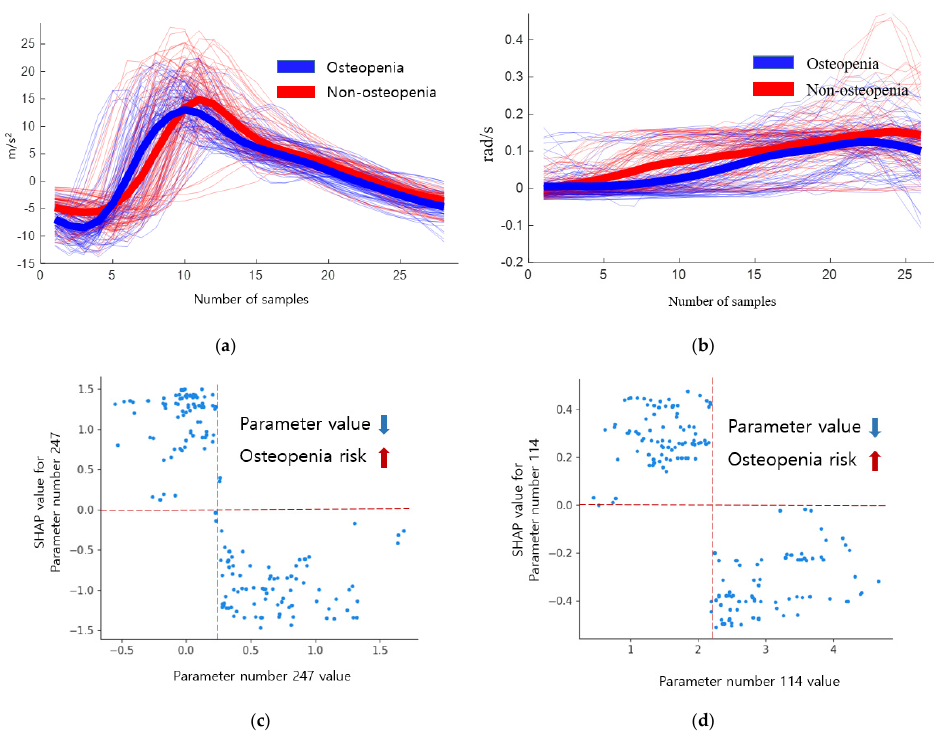
Table 13. Descriptive statistical parameters of osteopenia and sarcopenia. * indicates that the p -value is less than 0.025, and ** indicates that the p -value is less than 0.001. Osteopenia Sarcopenia Shapley Non-Sarco- Shapley Parameter Sarcopenia Value penia Value Figure 5. Inertial signals and SHAP dependence plots of descriptive statistical parameters 247 and 114 of osteopenia. ( a ) Inertial signal 247. ( b ) Inertial signal 114. ( c ) SHAP dependence plot 247. ( d ) SHAP dependence plot 114.